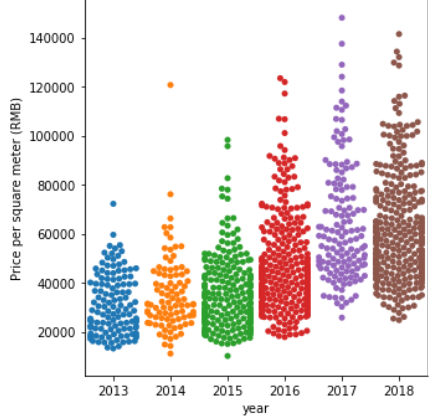
Figure 3. Resale price trend between 2013-2018 (sample of